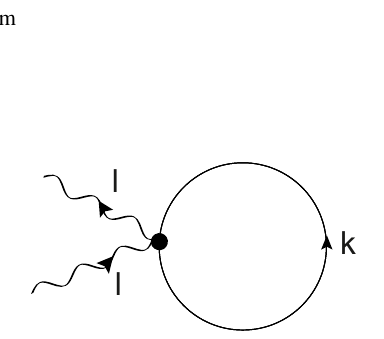
Figure 1. Bubble Feynman diagram